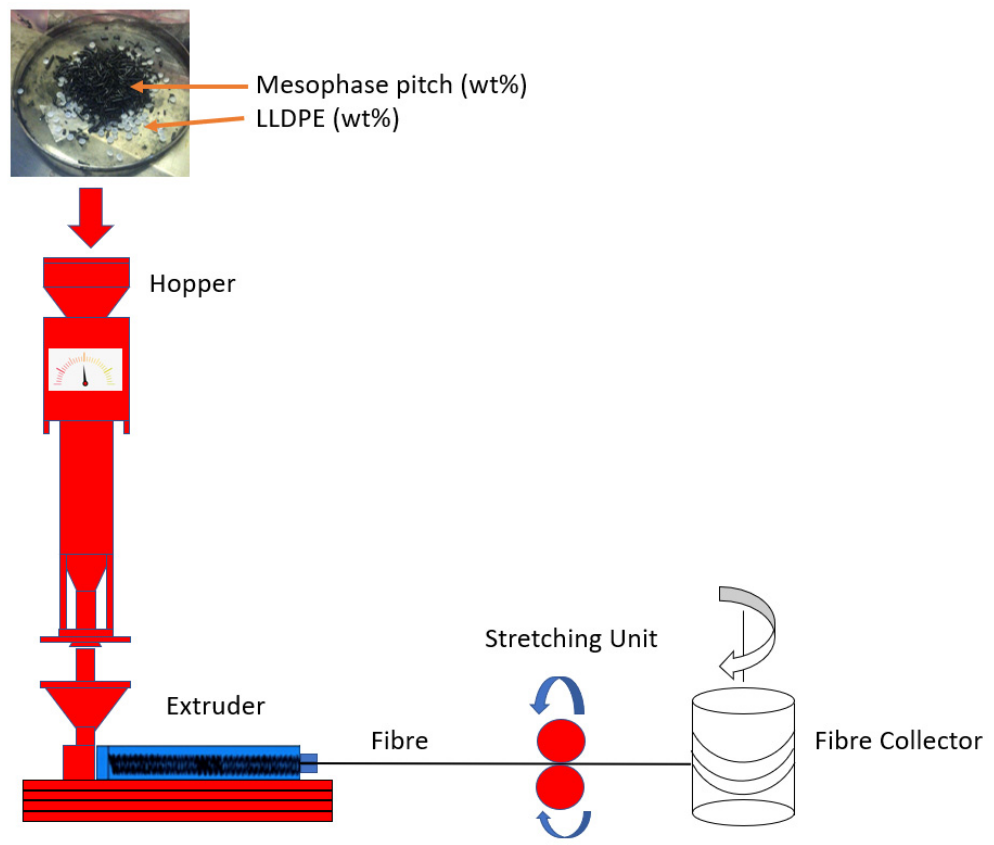
Figure 1. A flowchart of processing of materials.